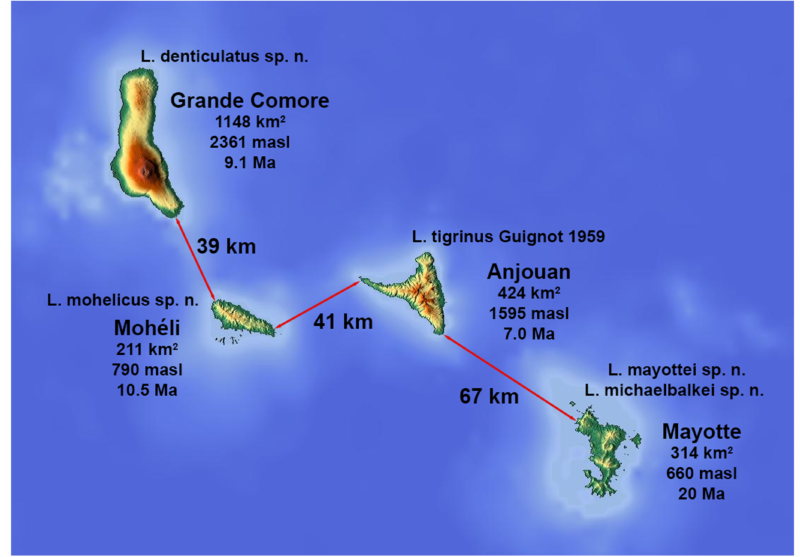
Figure 1. Topographic map of the Comoros archipelago, with indication of Laccophilus alluaudi group species occupancy based on our results. Terrestrial surface area in square kilometers and highest point in meters from [9], distance between islands in kilometers (calculated from Google Earth) and estimated beginning of magmatic activity in million years before present following [10] are given for each of the four main islands. Background map from https://maps-for-free.com, (accessed on 4 November 2021) released under Creative Commons